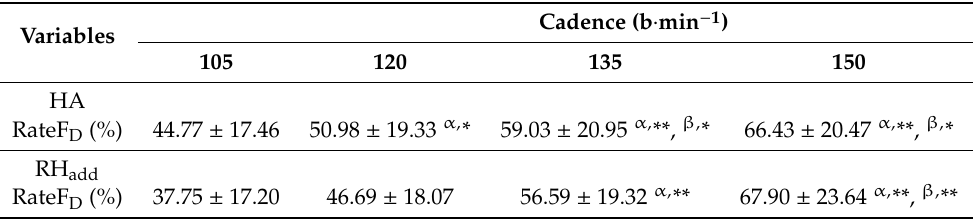
Table 2. Descriptive statistic (Mean ± SD) of the rate force production in two head-out water exercises at di ff erent cadences.